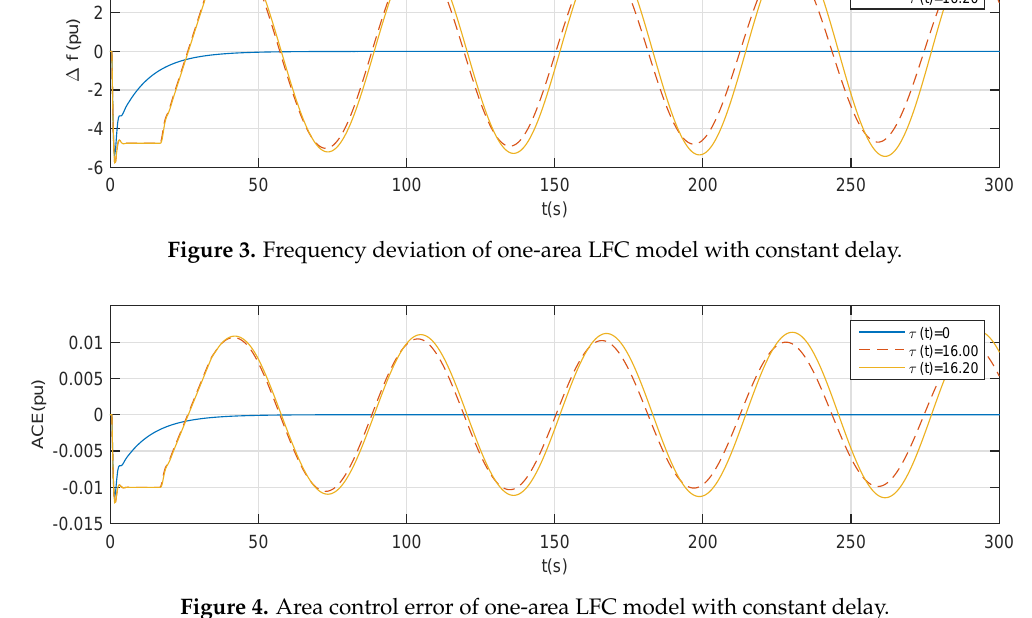
Figure 4. Area control error of one-area LFC model with constant